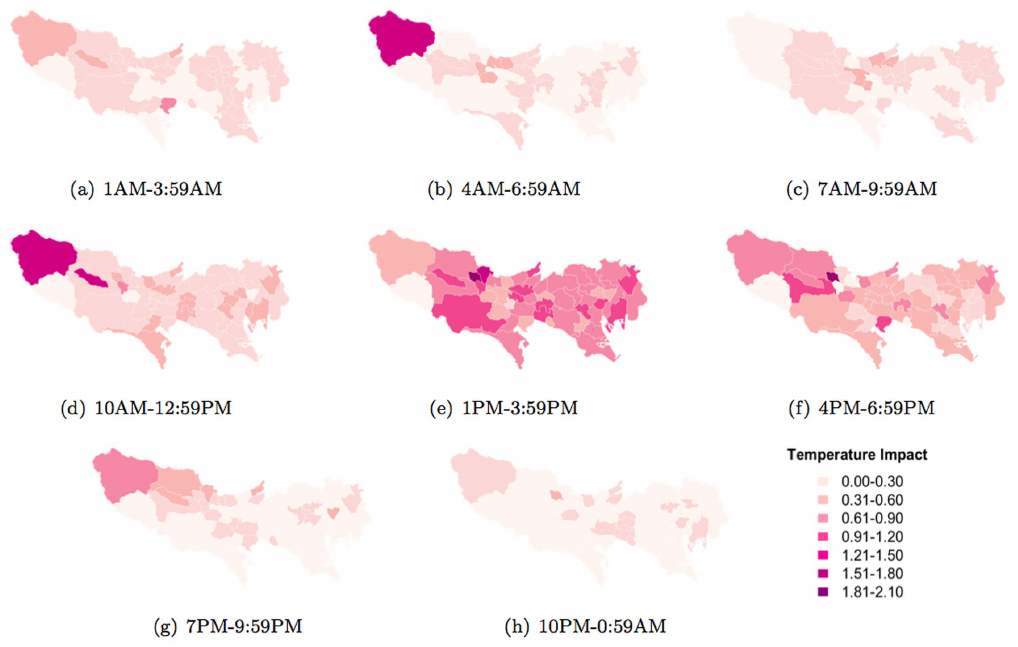
Figure 15. Temperature impact (change in entropy between normal and abnormal temperatures) on daily activity patterns across different municipalities.